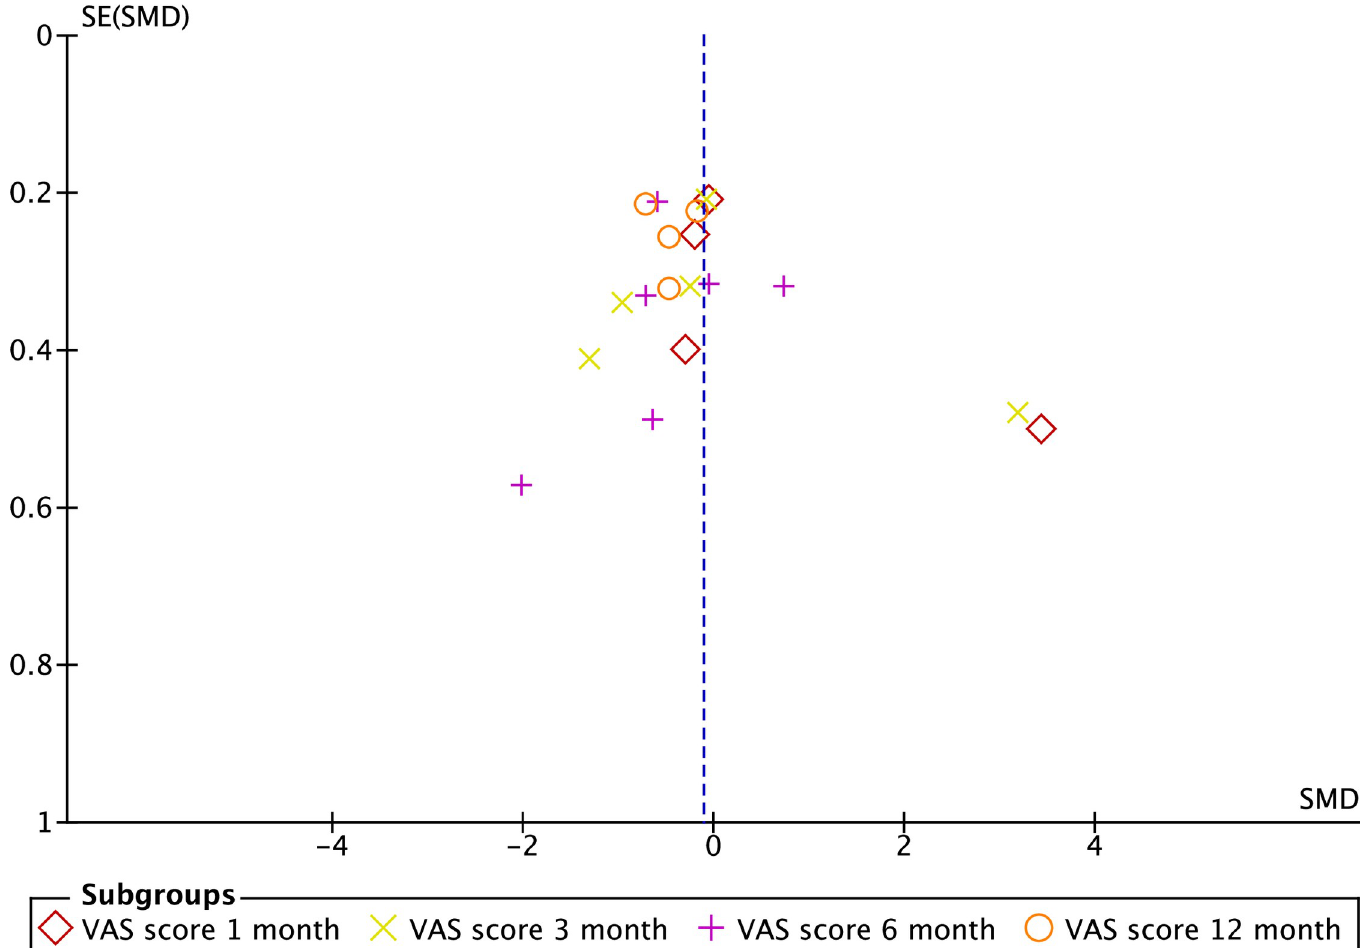
Fig 4. Funnel plot on VAS pain scores at 1, 3, 6, and 12 months